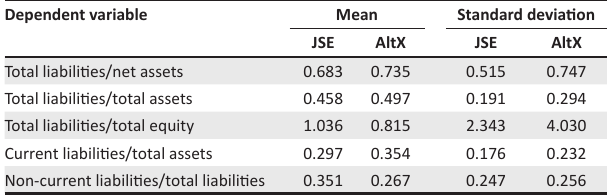
TABLE 4: Descriptive statistics of the dependent